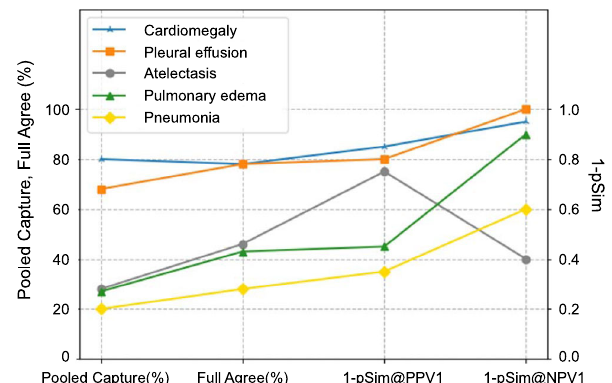
Fig. 6 Comparison of labeling ef fi ciency/con fi dence metrics for each of the 5 clinical output labels. For each of the fi ve auto-labeled clinical output labels – cardiomegaly (blue), pleural effusion (orange), atelectasis (gray), pulmonary edema (green), and pneumonia (yellow) — we compared: (i) the percent of positively auto-labeled CXR ’ s “ captured ” from the three pooled, full public datasets (i.e., “ Pooled Capture% ” , from Supplementary Table 3, C); (ii) the percent of cases with complete agreement between the model and all seven expert readers (i.e., “ Full Agree% ” , from Supplementary Fig. 2); (iii) the lowest pSim value such that PPV = 1 (graphed as “ 1-pSim ” , from Figs. 2 – 4, c), and (iv) the lowest pSim value such that NPV = 1 (graphed as “ 1-pSim ” , from Figs. 2 – 4, d). clinical output labels with higher y-axis values (e.g., cardiomegaly, pleural effusion) correspond to those with greater model auto-labeling ef fi ciency/con fi dence; clinical output labels with lower y-axis values (e.g., pneumonia, pulmonary edema) correspond to those with lesser model auto- labeling ef fi ciency/con fi dence. Of note, in the graph for atelectasis, “ 1- pSim@PPV1 ” is higher than “ 1-pSim@NPV1 ” , which can be interpreted as greater con fi dence that the model is correct in “ ruling-in ” the clinical output label (i.e., correctly auto-labeling true-positives) than in “ ruling-out ” the clinical output label (i.e., correctly auto-labeling true-negatives); this relationship is reversed for the other four clinical output labels (e.g., greater con fi dence that the model can correctly “ rule-out ” than “ rule-in ” pneumonia or pulmonary